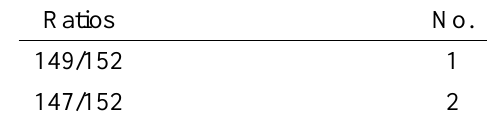
Ratio used for the correction Sm fractionation Ratios